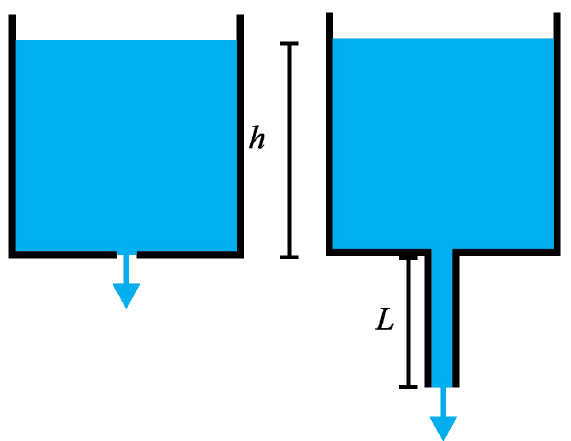
FIG. 9. Open container with water kept at a constant level h . The fluid drains through a pipe which ends with a vertical section of length L . Four points, A , B , C , and D are represented, two inside the pipe and the other two after the mouth of the